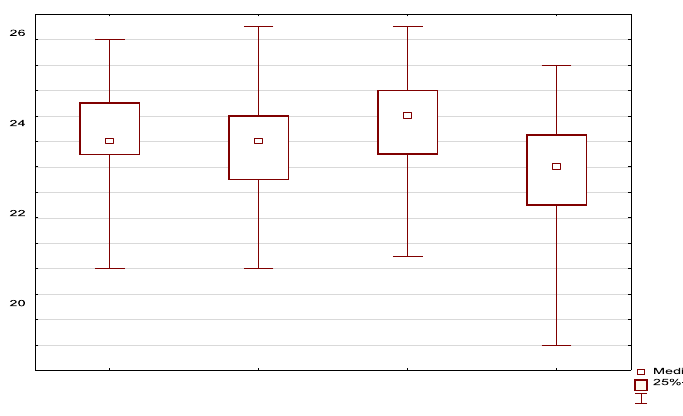
Note: Sample n = 441. Figure 3. Distribution of results for overadaptation in individual populations